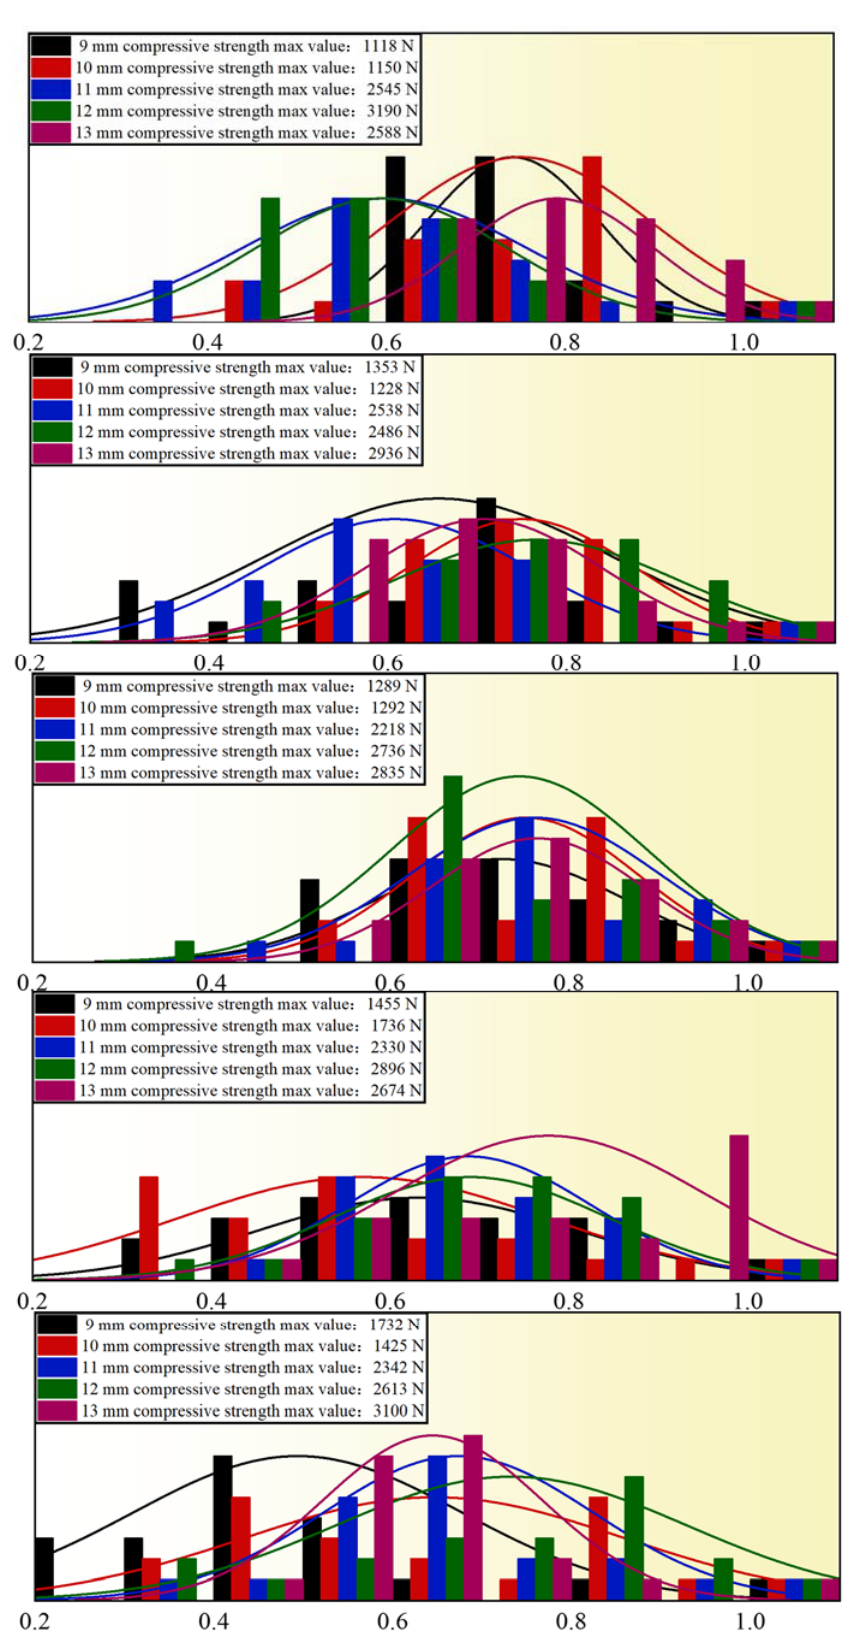
Figure 10. Normality test of pellet compressive strength under the influence of pellet diameter.